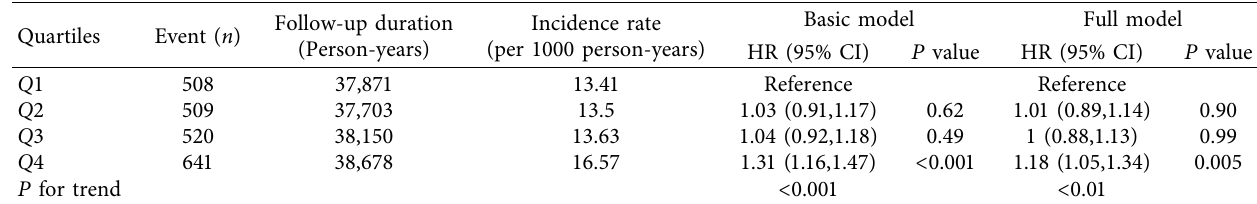
Table 2: The associations between TyG variability quartiles and CVD.